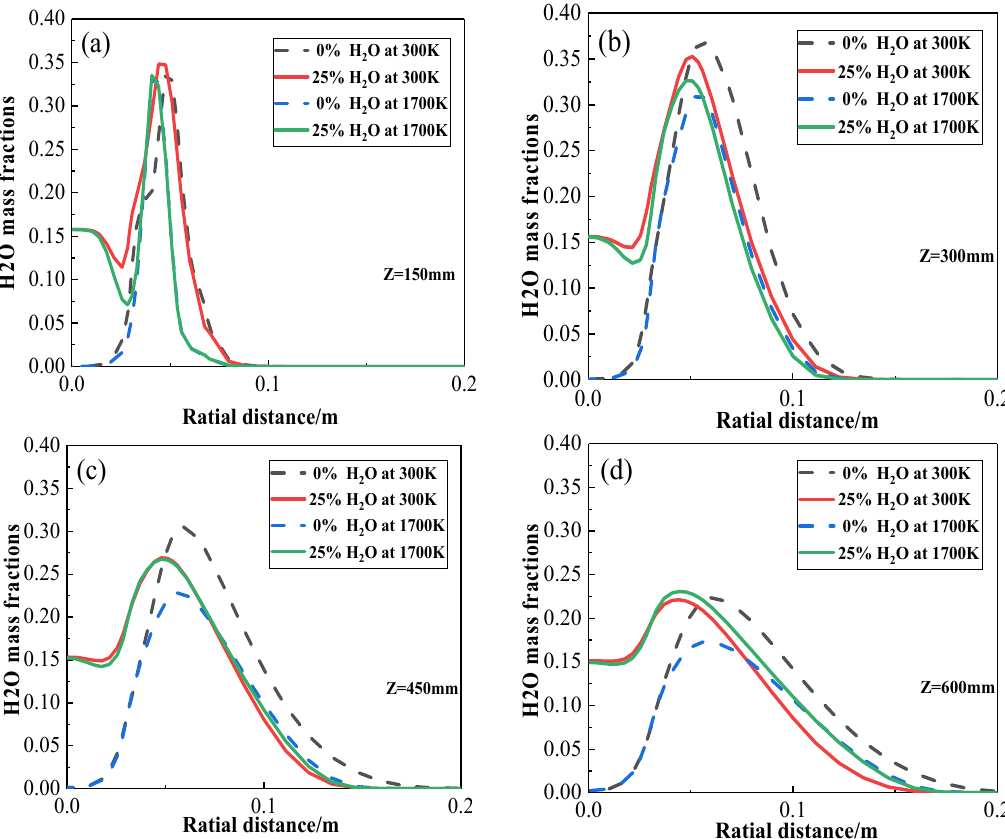
Figure 15. Radial distributions of H 2 O at different positions from the spray gun outlet at 300 and 1700 K: ( a ) Z = 150 mm, ( b ) Z = 300 mm, ( c ) Z = 150 mm, and ( d ) Z = 600 mm.